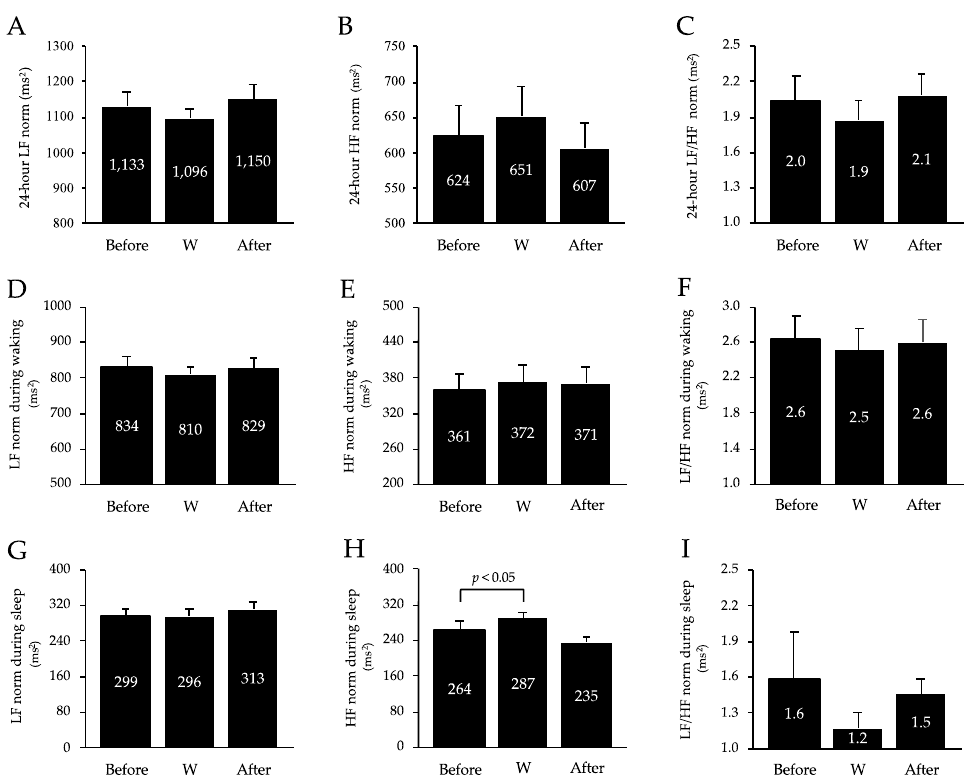
Figure 4. Changes in 24 -hour LF norm ( A ), HF norm ( B ), and LF/HF norm ( C ), LF norm ( D ), HF ( E ), and LF/HF ( F ) during waking, and LF norm ( G ), HF ( H ), and LF/HF ( I ) during sleep. Values are mean ± SD. W, workcation; LF, low-frequency; HF, high-frequency.